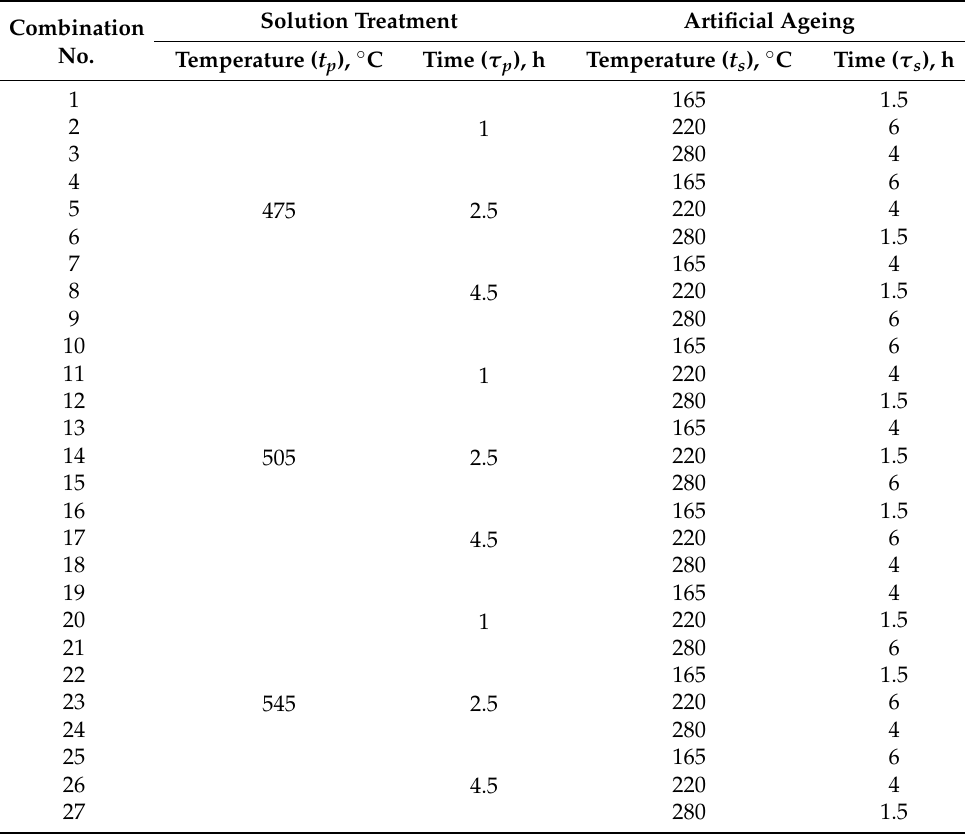
Table 2. The test piece heat treatment